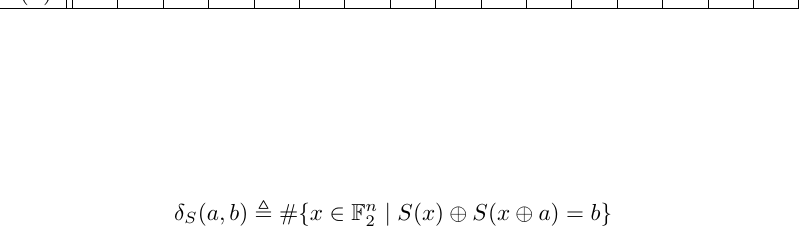
Table 7: Lookup table of the first 4 × 4-bit S-box S 0 used in Serpent x